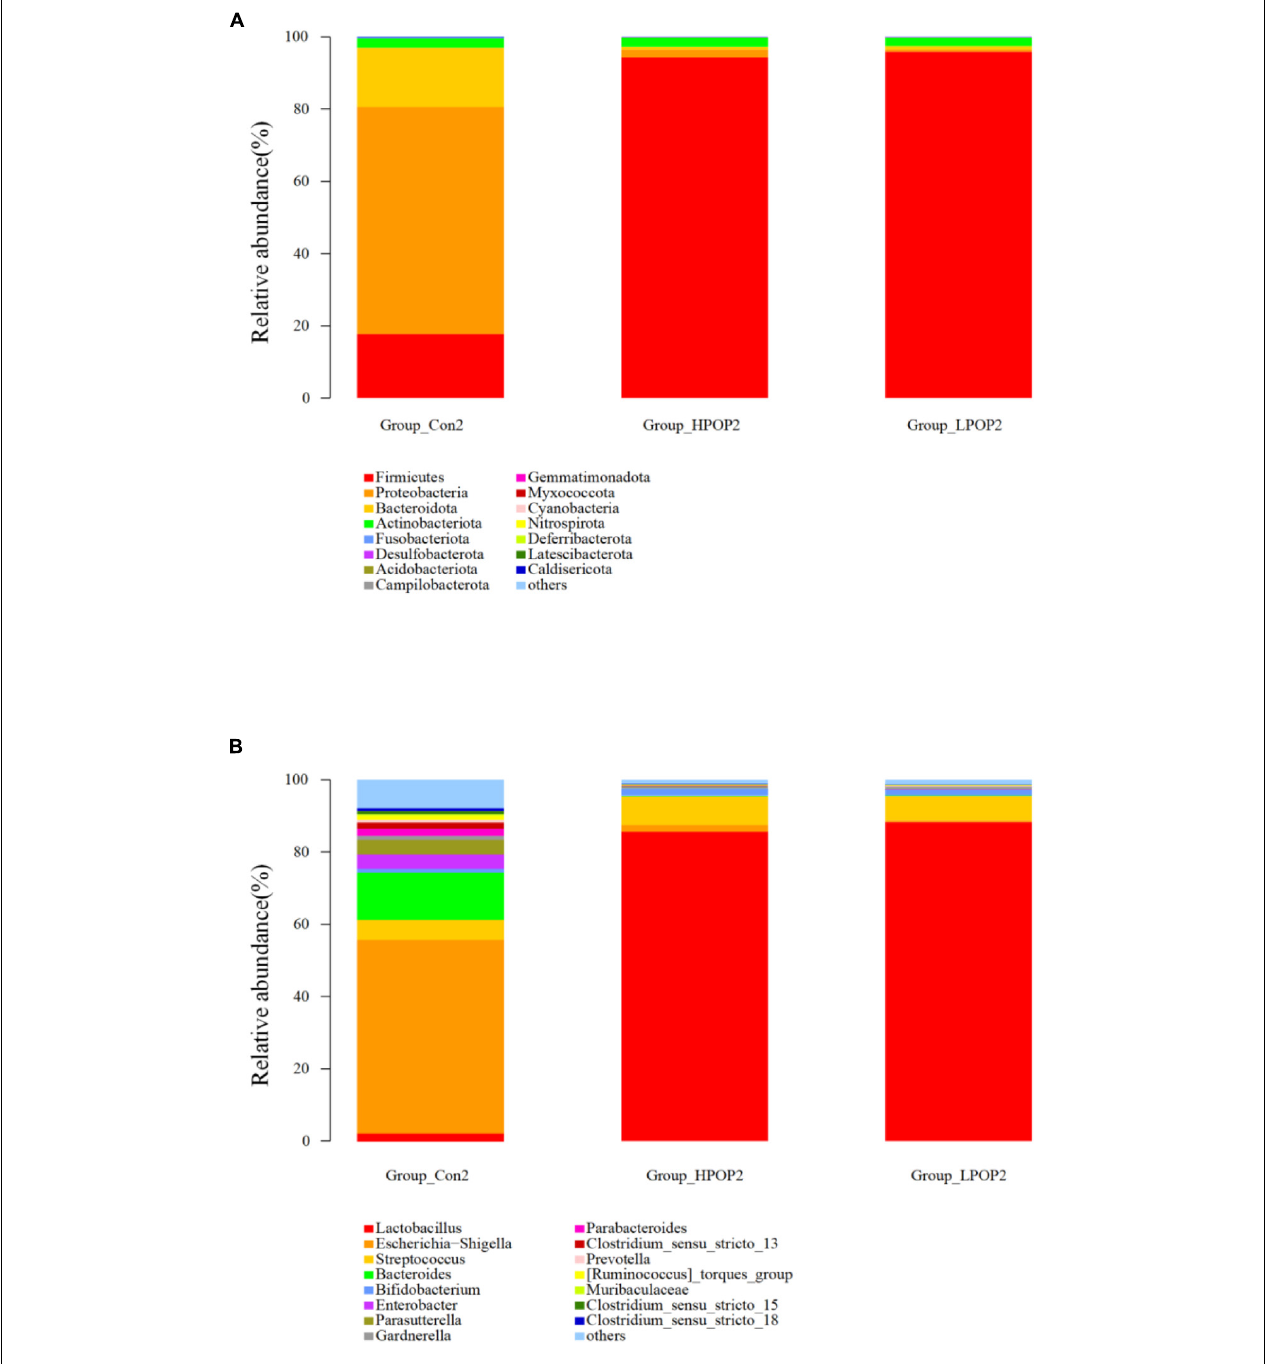
FIGURE 5 | Effects of POP on microbial composition of the fermentation (phylum and genus levels). Changes of microbiota composition at phylum (A) and genus (B) levels at 48 h in vitro fecal fermentation with